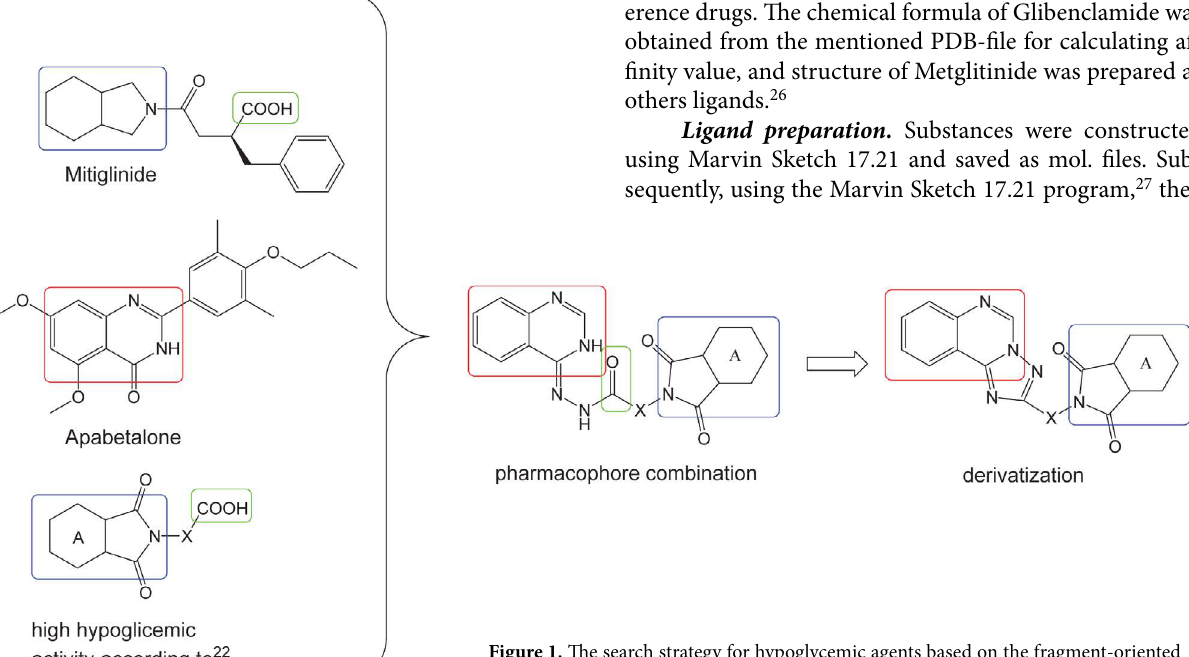
Figure 1. The search strategy for hypoglycemic agents based on the fragment-oriented design (combination of isoindole and quinazoline moieties in